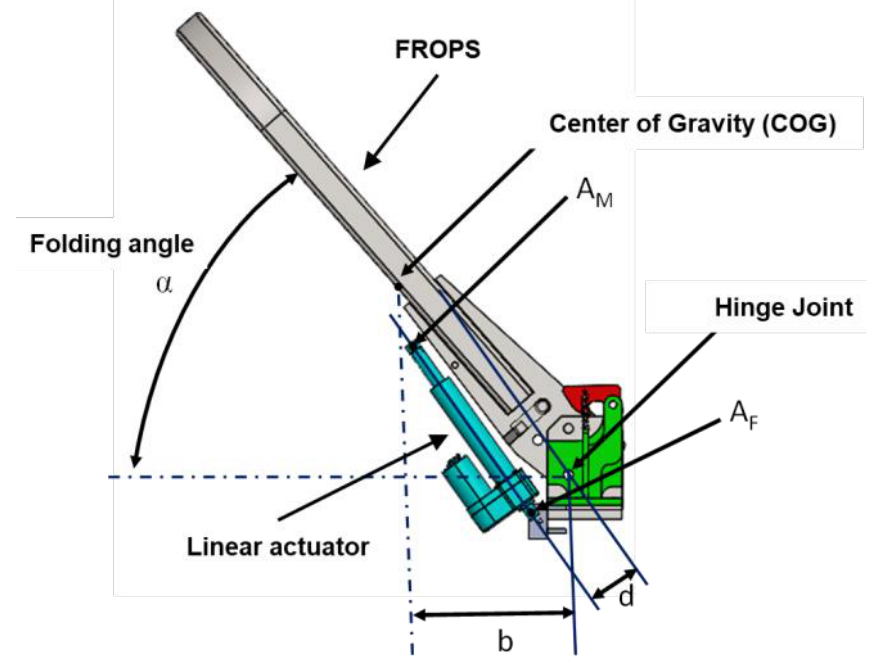
Figure 5. Model of the geometrical features of the linear actuator (A F and A M represent the anchorage points of the actuator).